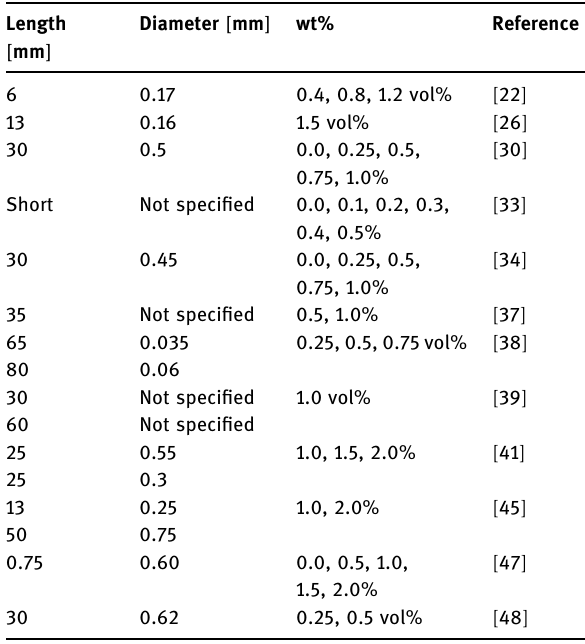
Table 1: Characteristics of the short steel fi ber - reinforced geopolymers